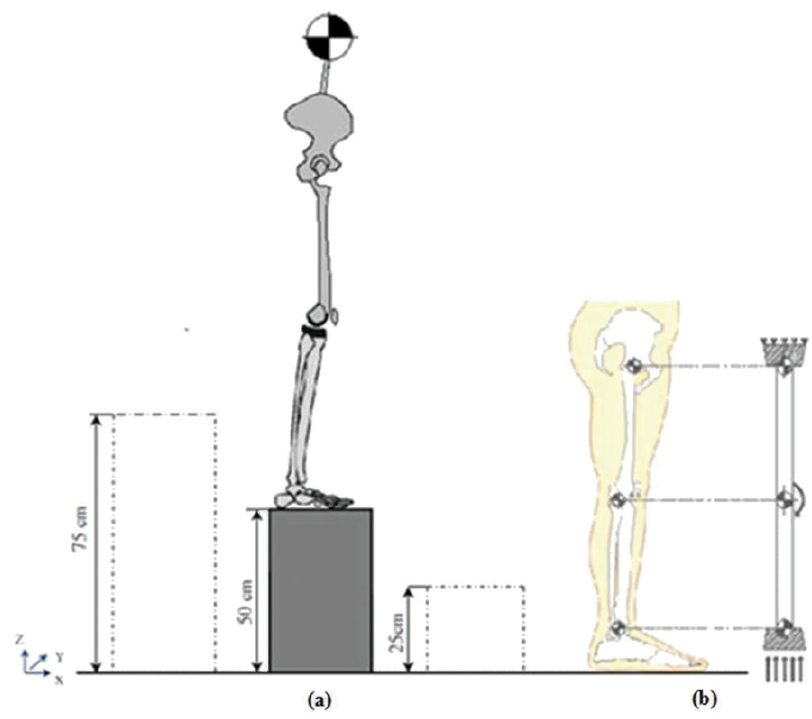
Figure 1 - Force simulation of free extended-knee